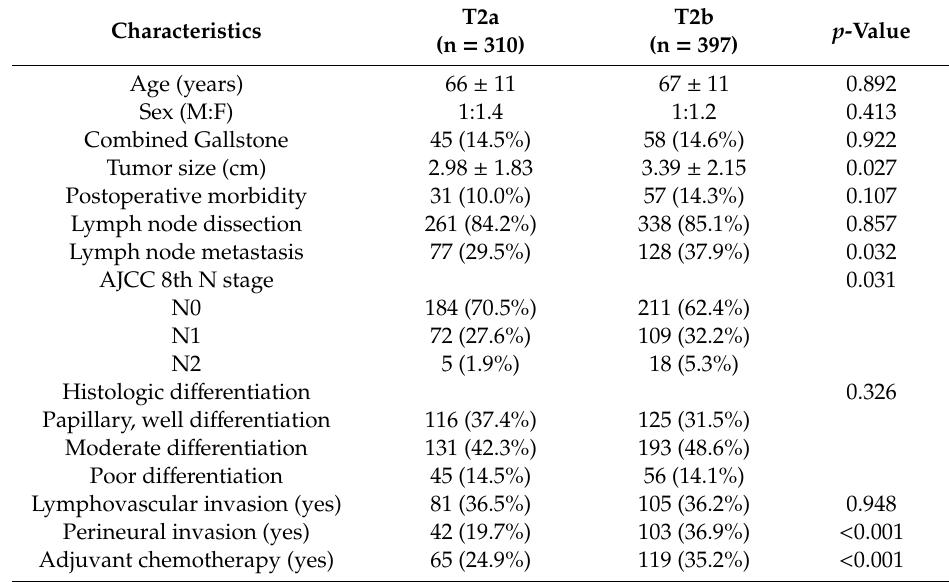
Table 1. Clinicopathological characteristics of enrolled patients according to tumor